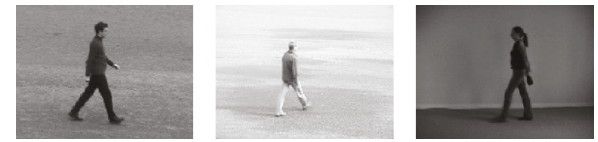
Figure 1: Samples of KTH dataset.